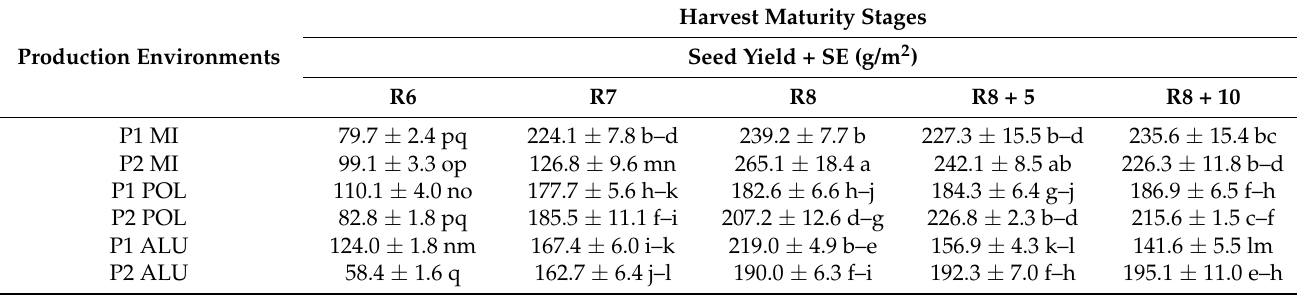
Note: Means values marked with different small letters indicates significant difference at p < 0.05